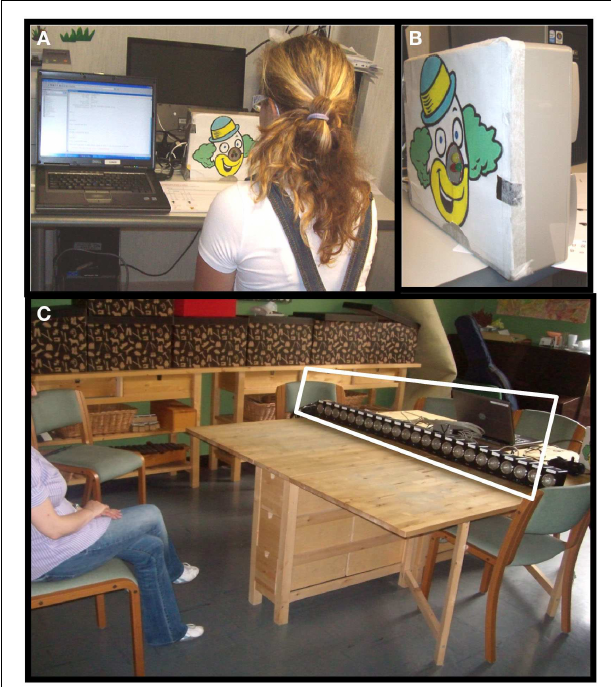
FIGURE 1 | (A) Representation of the setup used for the temporal bisection task while a subject is tested. (B) Image reporting the setup used for the temporal bisection task.Three lights are presented in front and two speakers are present behind. (C) Representation of the setup used for the space bisection task.The blurring panel was positioned in front of the speakers so that the subject could not see the speakers behind it. For illustrative purposes this has been replaced with a transparent panel to show the